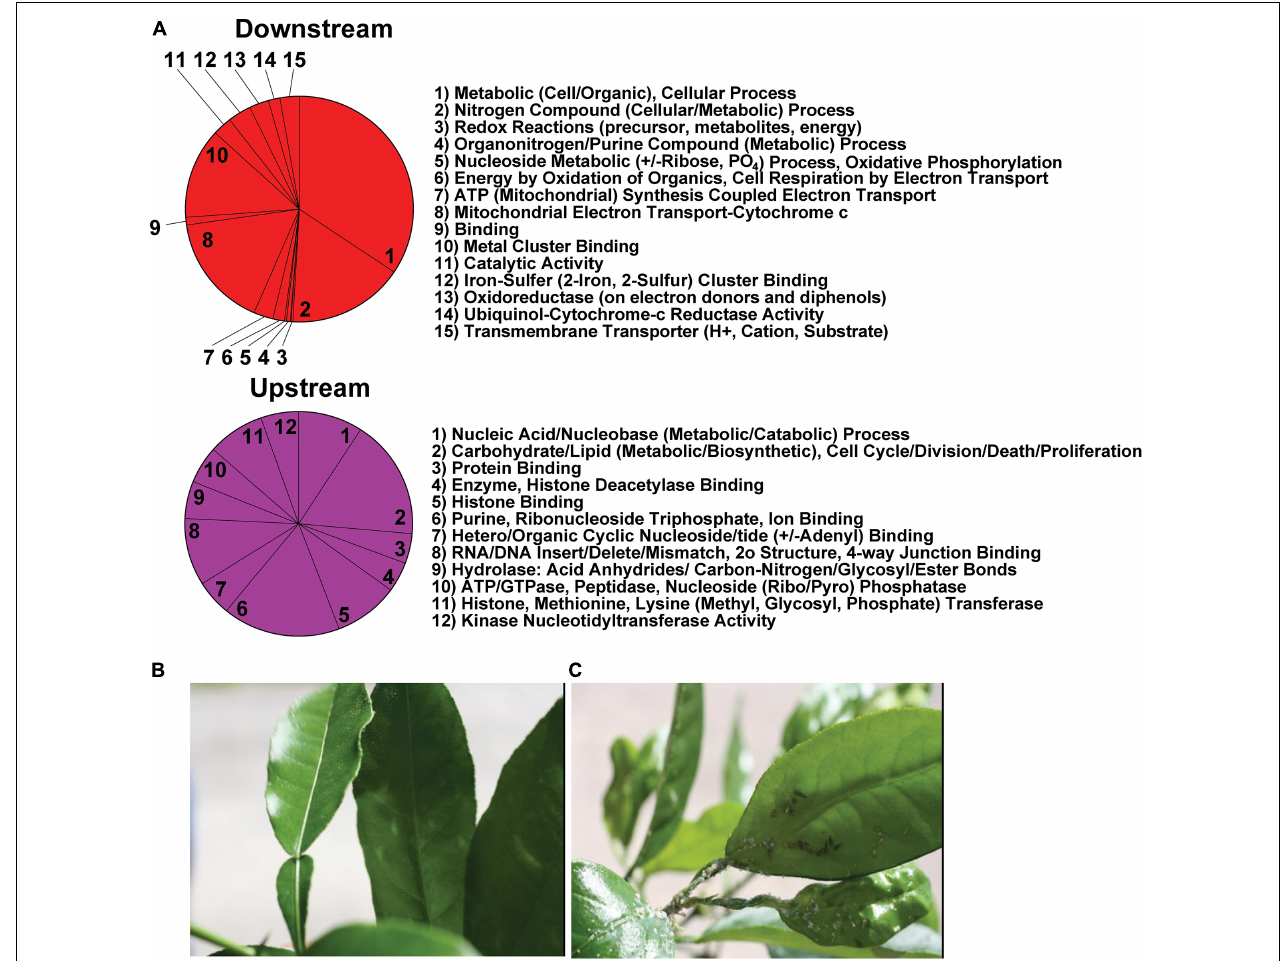
FIGURE 3 | (A) Ontological processes arranged by upstream and downstream biological processes and unrelated effects after dsRNA- RIE targeting. Downstream and upstream effects that are not related specifically to down regulation of Rieske on the red and magenta pie charts include for downstream events: Nitrogen, Organonitrogen/Purine, Nucleoside and cellular and metabolic processes, and for upstream effects: RNA/DNA, and Nucleotide (Organo/Hetero) binding, metabolism, catabolism, hydrolysis, modification and repair as well as carbohydrate and lipid metabolism. (B) Citrus leaves infected with CTV-RIE are resistant to D. citri infestation, whereas (C) non-infected citrus leaves are not resistant to D. citri infestation.